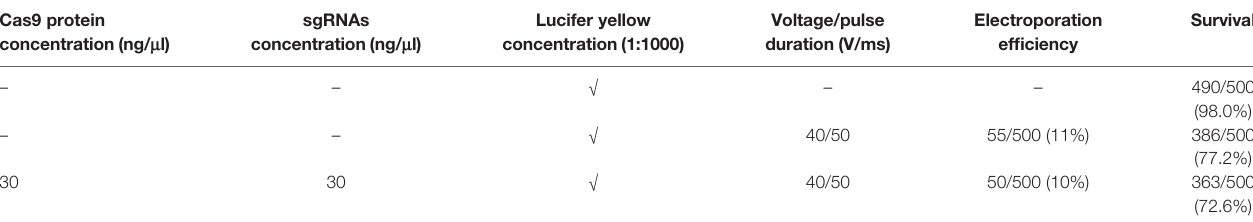
TABLE 2 | Summary of electroporation ef fi ciency and survival rate. Cas9 protein concentration (ng/ m